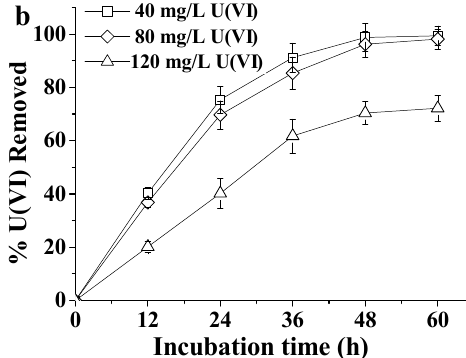
Figure 2. Figure 2. The U(VI) removal capacities of the ATCC 9372 strain ( a ) and the Ua strain ( b ). All experiments were performed in triplicate. The average results of three experiments were shown; bars represent standard deviations.